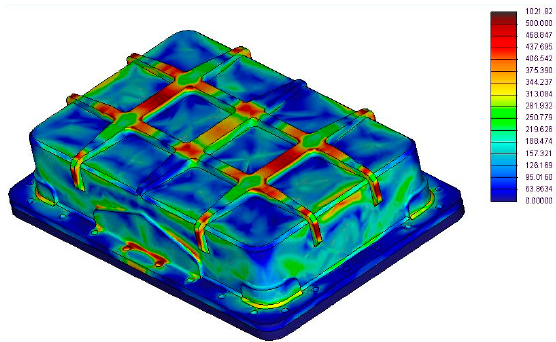
Figure 10. Stress distribution during an explosion simulation (final design).